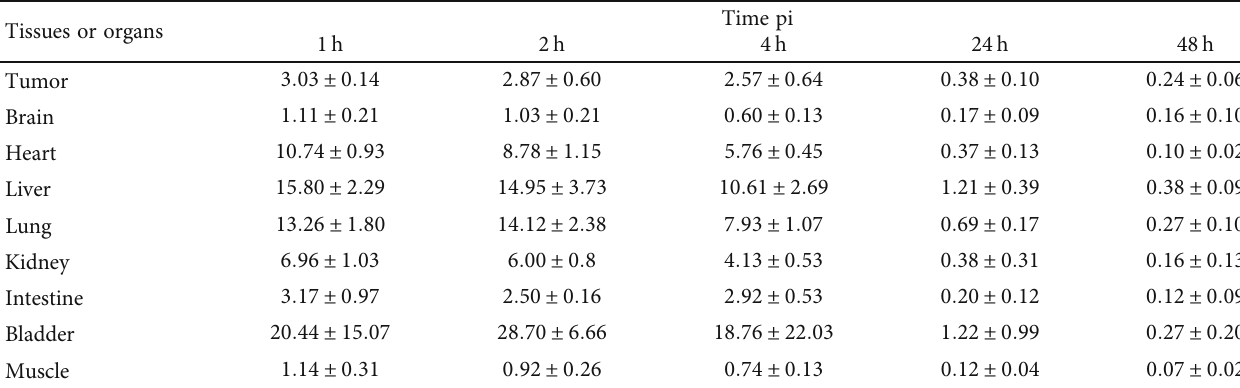
Table 2: Distribution of 125 I-WT-pHLIP in MDA-MB-231 tumor-bearing nude mice (%ID/g, n = 4 ). Tissues or